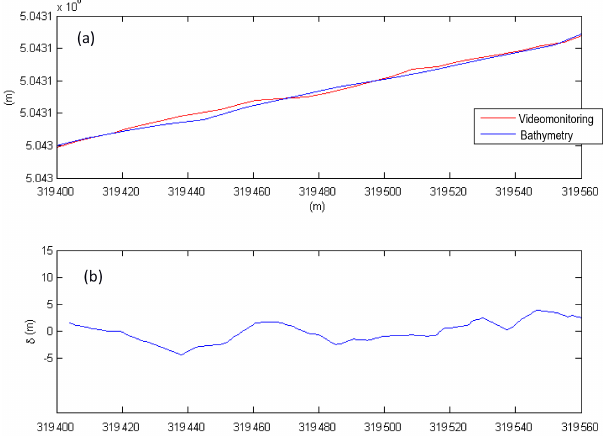
Figure 7. Comparison between video-image-derived and in situ RTK-GPS shorelines: (a) difference between shorelines detected from image (the red line) and from bathymetry survey (the blue line) date 30 September 2014; (b) the cross-shore deviation between the RTK-GPS shoreline and the image derived shoreline taken at the survey date. Negative deviation values represent a more landward video-derived